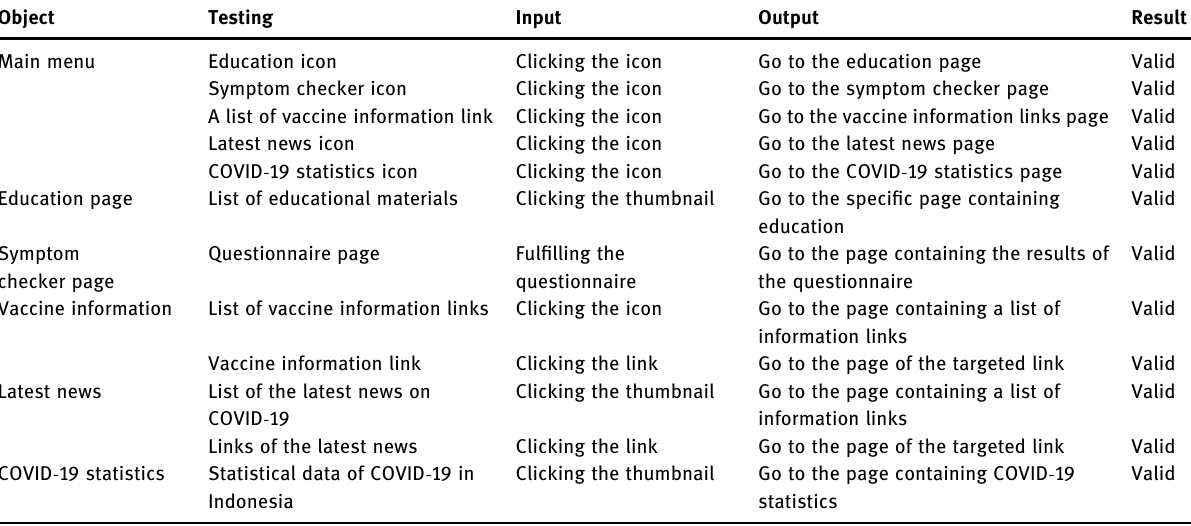
Table 4: Results of black - box testing of the educational app